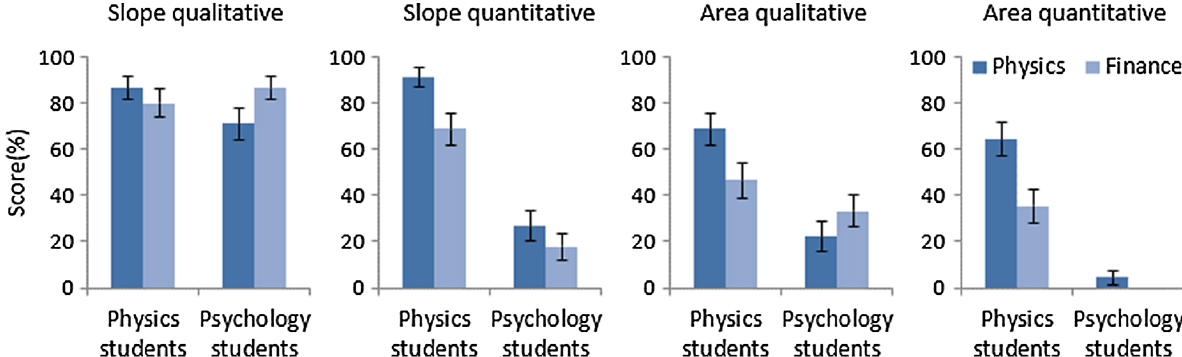
FIG. 3. Average scores of physics and psychology students in the context of physics and finance on the qualitative and quantitative questions about graph slope and area under a graph. The error bars represent 1 SEM.